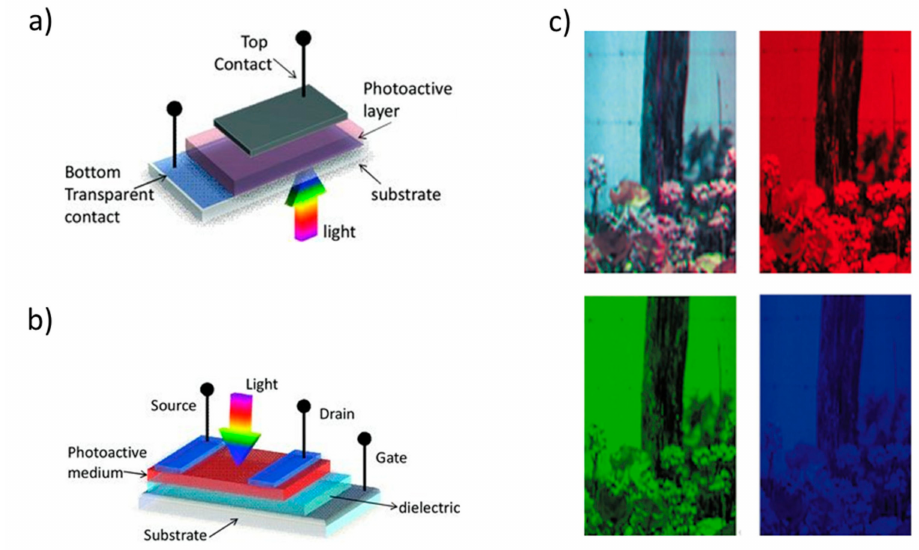
Figure 1. Typical device configurations of photodetectors: ( a ) a photodiode with vertical geometry illuminated from the bottom-side and ( b ) a phototransistor with the light window entrance on the top. Reproduced with permission from [30] © 2020 by WILEY-VCH Verlag GmbH & Co. KGaA, Weinheim. ( c ) full-color image (with the corresponding monocolor, R, G and B images) taken by an organic photodetector (OPD) array. Adapted with permission from [31] © 2020 by WILEY-VCH Verlag GmbH & Co. KGaA,